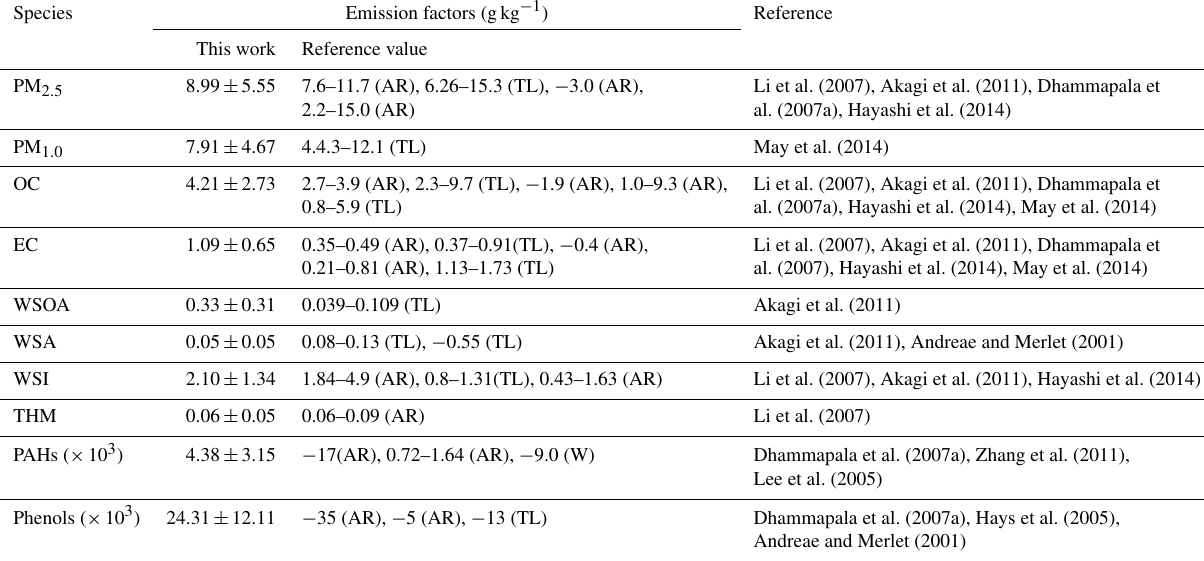
Table 3. Comparison of emission factors with the literature (specific chemical materials in the form of PM 2 . 5 )